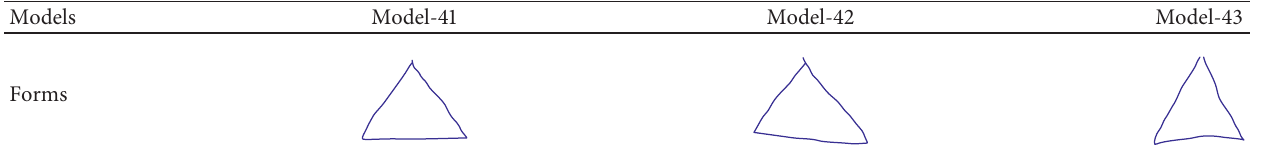
Table 9: . Examples of “triangle” written by